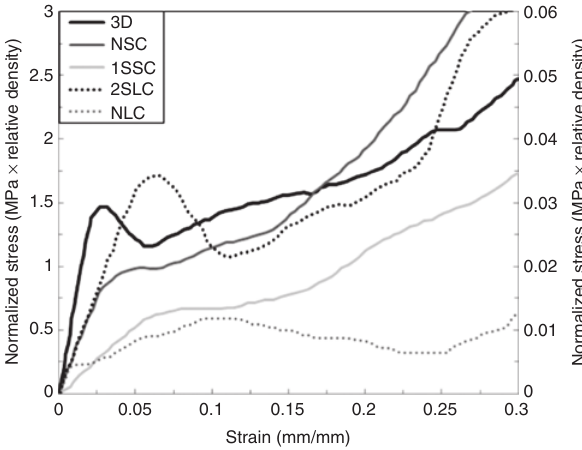
Figure 7 Quasi-static (0.001 s -1 ) compressive stress-strain response with compressive stress multiplied by relative density (MPa × ρ / ρ ) plotted against strain. Note that the large-cell foams 0 (i.e., 2SLC and NLC) are plotted against the secondary axis on the right side of the